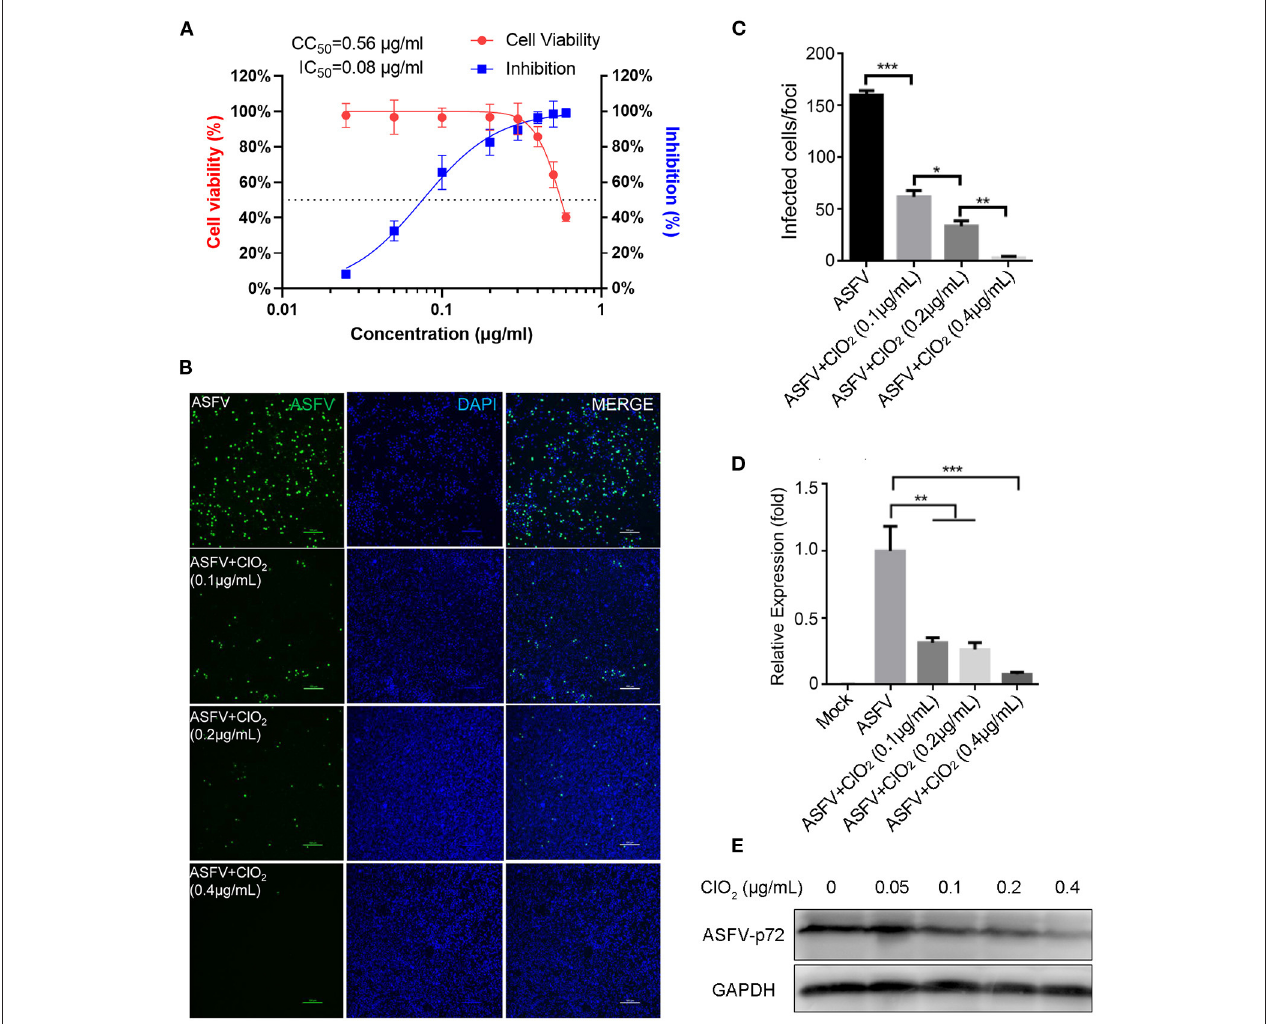
FIGURE 1 | ClO 2 restrains ASFV replication in a dose-dependent manner in PAMs. (A) Dose response curves showing the effect of ClO 2 on inhibition of ASFV infection (blue) and cytotoxicity (red) in PAMs. The IC 50 was determined by analyzing the cell infection rate from IFA images, and the CC 50 was evaluated using the CCK-8 assay. The left and right Y-axis represent virus inhibition (%) and cell viability (%) of ClO 2 , respectively. (B) PAMs were infected with ASFV (MOI = 1) in the presence of various concentrations of ClO 2 . After incubation for 24h, cells were harvested for fluorescence microscope examination. Bar, 100 µ m. (C) Average number of infected cells per foci in cells treated as B. (D,E) PAMs were mock-infected or infected with ASFV at an MOI of 1, and simultaneously co-treated with different concentrations of ClO 2 for 24h. Cells were then collected for the detection of viral p72 mRNA (D) and protein (E) levels by qRT-PCR and western blot analysis, respectively. Data are representative of the results of three independent experiments (means ± SE). Significant differences compared with control group are denoted by * P < 0.05, ** P < 0.01, and *** P <